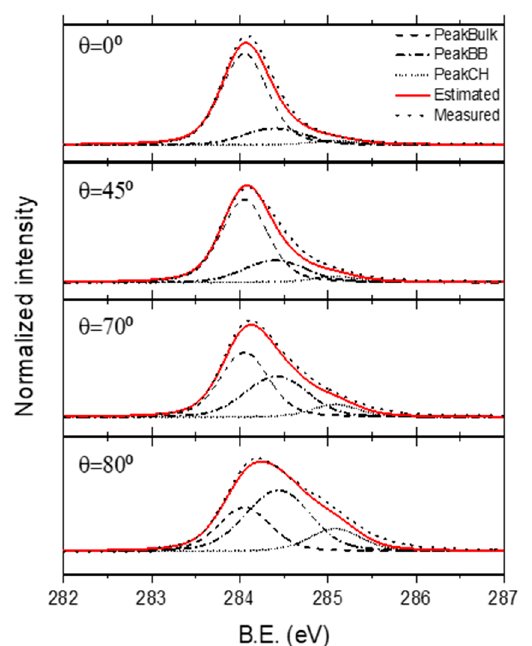
Figure 5. ARXPS C 1s measured spectra (black dotted) and accumulated deconvolution (red line). The deconvoluted spectra are formed by three peaks each: Peak bulk (dashed), Peak bb (dashed-dot), and Peak CH (short-dotted) corresponding to the diamond bulk region, diamond depleted region, and 1 ML of surface C–H, respectively. For the generation of the Peak bb , band bending width, d , and band bending maximum potential, V bb , were found to be 0.5 nm and 0.67 eV, respectively.